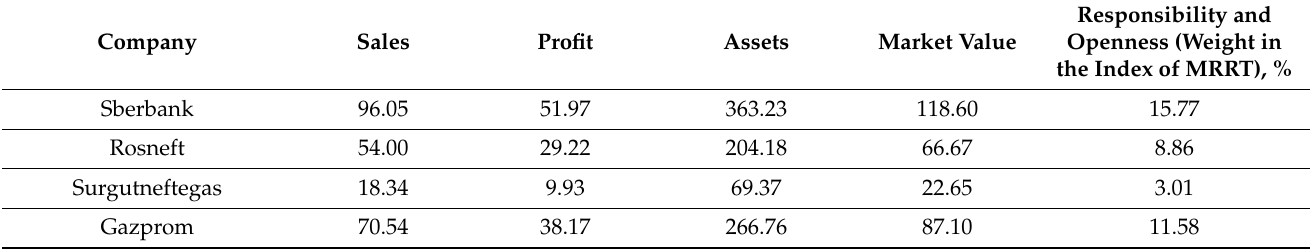
Table A2. Expected values of five